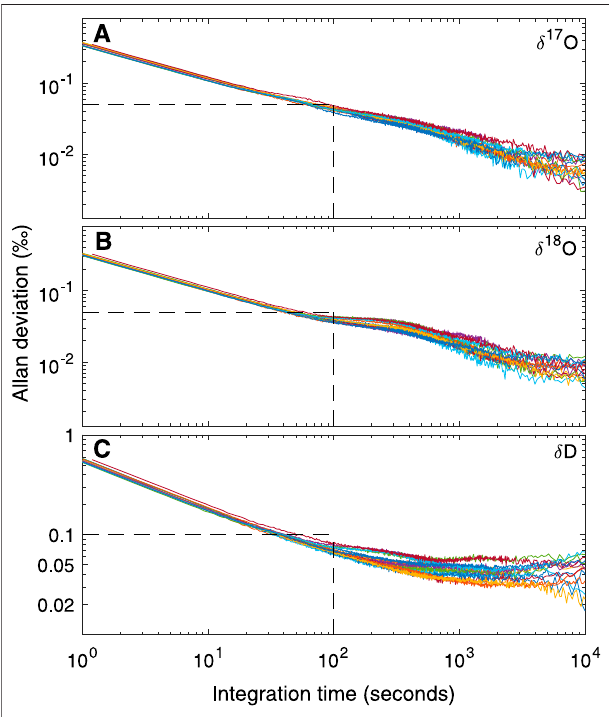
FIGURE 2 | Allan deviation for (A) δ 17 O (B) δ 18 O, and (C) δ D from fi fteen long reference water measurements using the CFA system. Each color represents a different day of measurements. Dashed lines illustrate that for integration times of 100 s, precision is less than 0.05 ‰ for δ 17 O and δ 18 O and < 0.1 ‰ for δ D.